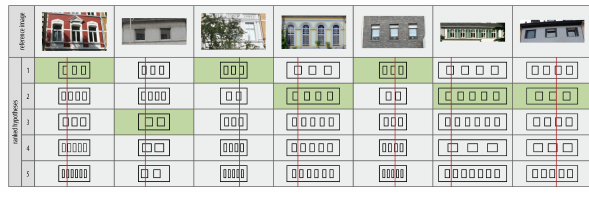
Figure 2: Ranked fac¸ade hyptheses derived using constraint propagations and stochastic reasoning (Loch-Dehbi and Pl¨umer,